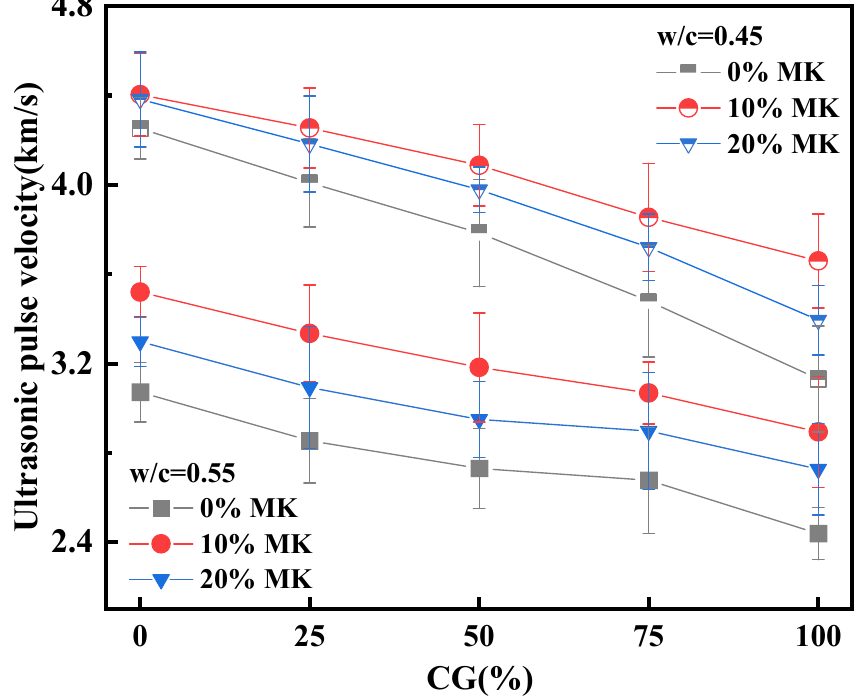
Figure 3. Variation of ultrasonic pulse velocity of different concrete mixtures.